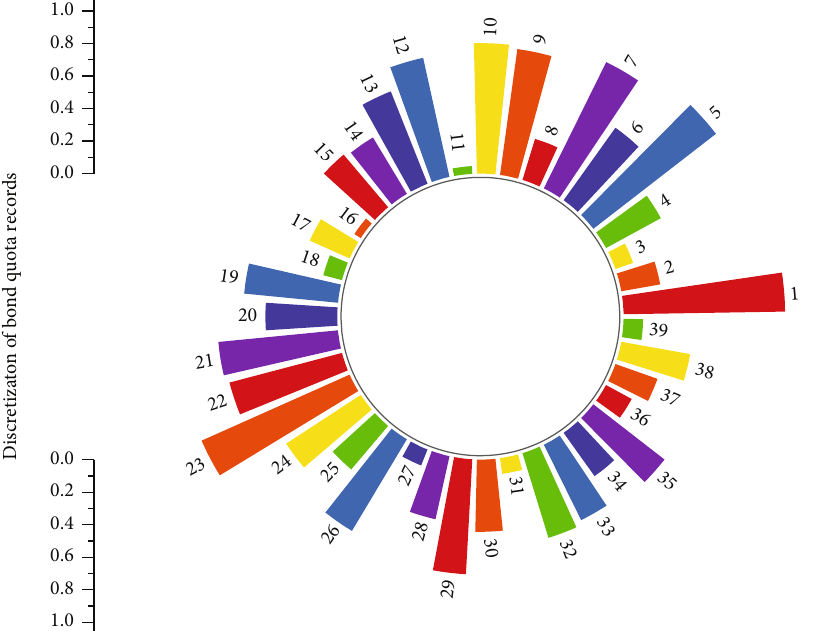
Figure 9: Discretization of bond quota